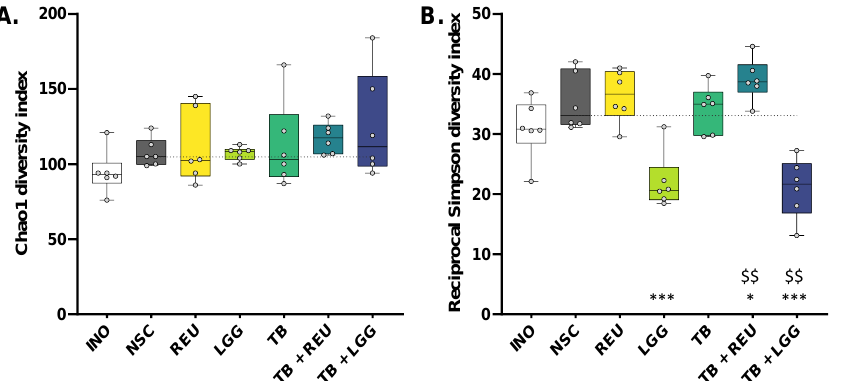
Figure 4. Microbial diversity was maintained in the SIFR ® technology (from INO to NSC), with TB + REU further increasing diversity. Impact of two Lactobacillaceae species (LGG and REU), tribu- tyrin oil (TB), and combinations thereof, on the ( A ) Chao1 diversity index and ( B ) the reciprocal Simpson diversity index (n = 6). Samples were collected at 0 h (INO) and after 48 h of simulated colonic incubations. The line in the box plot is shown at the median value in the NSC. Statistical differences compared to the NSC are indicated with * (0.10 < p adjusted < 0.20), ** (0.05 < p adjusted < 0.10) or *** ( p adjusted < 0.05), while differences between TB + REU/TB + LGG and TB are indicated with $$ (0.05 < p adjusted < 0.10). REU = Limosilactobacillus reuteri ; LGG = Lacticaseibacillus rhamnosus.